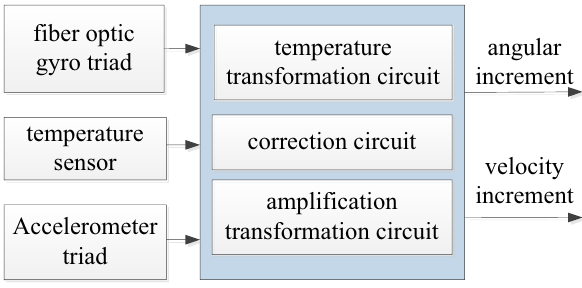
Figure 2. Functional principle diagram of the inertial measurement